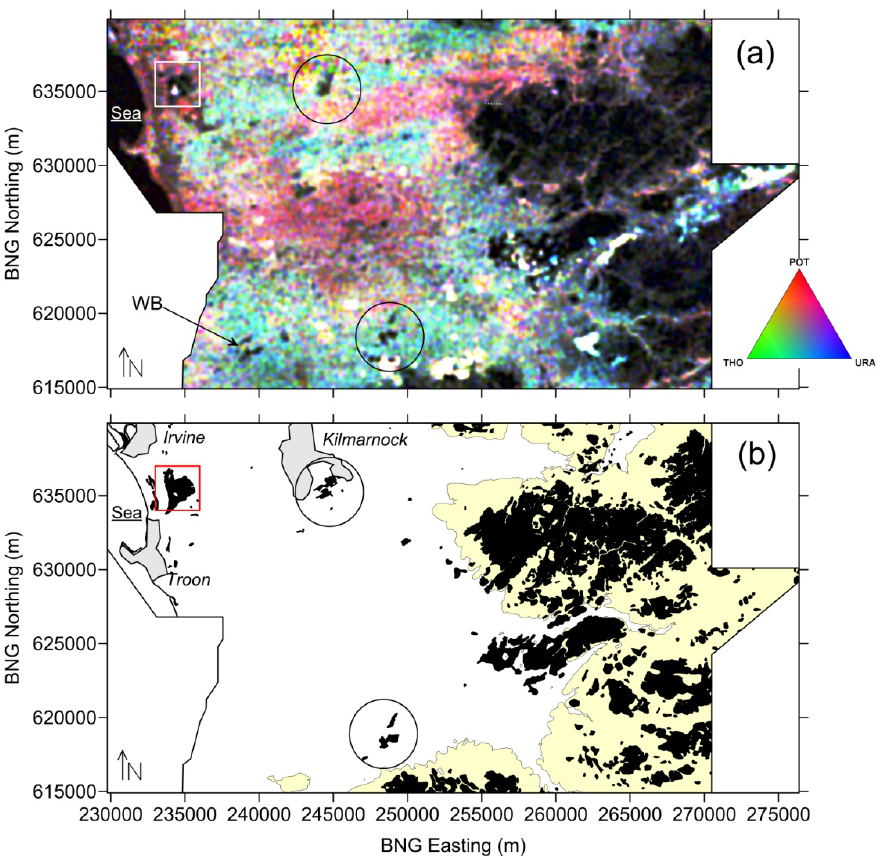
Figure 3. ( a ) Radiometric data from the Ayrshire survey shown as a ternary colour image (a 3-way colour stretch of the Potassium, Thorium and Uranium components) of the data. WB denotes a water body. Circles denote two lowland areas of peat. ( b ) Areas of peat defined by DiGMAPGB50 mapping of peat (zones in black). Infilled area (in the south and east) defines elevations greater than 200 m. Red rectangle is a 3 × 3 km area of peat that is used for a more detailed